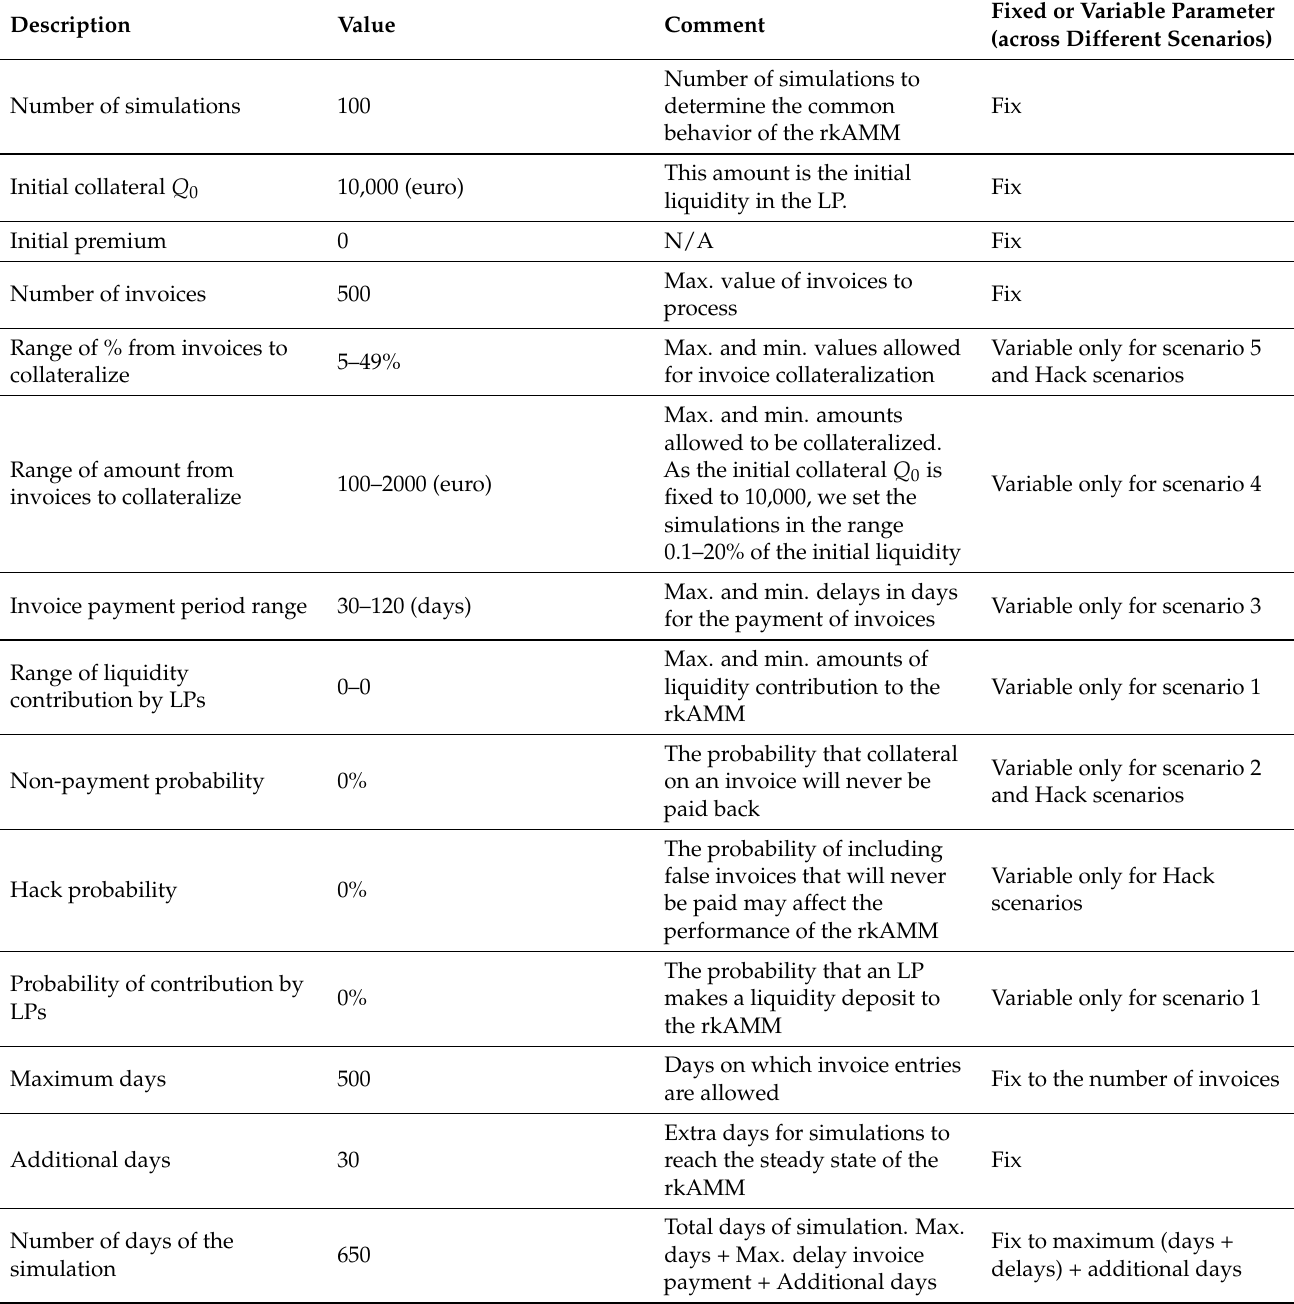
Table 7. Attributes used to simulate default (non-payment) and hack